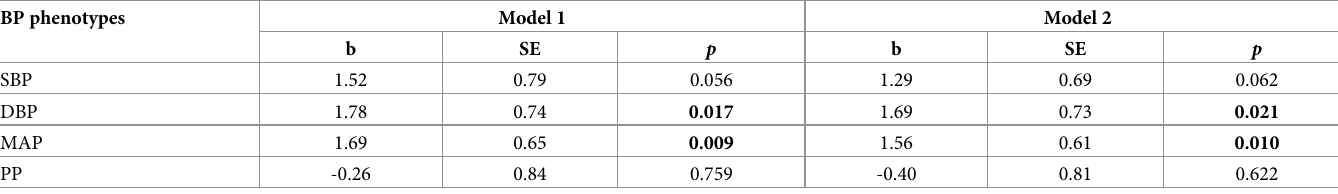
Table 2. Association between the CACNA1D rs9810888 polymorphism and blood pressure phenotypes. BP